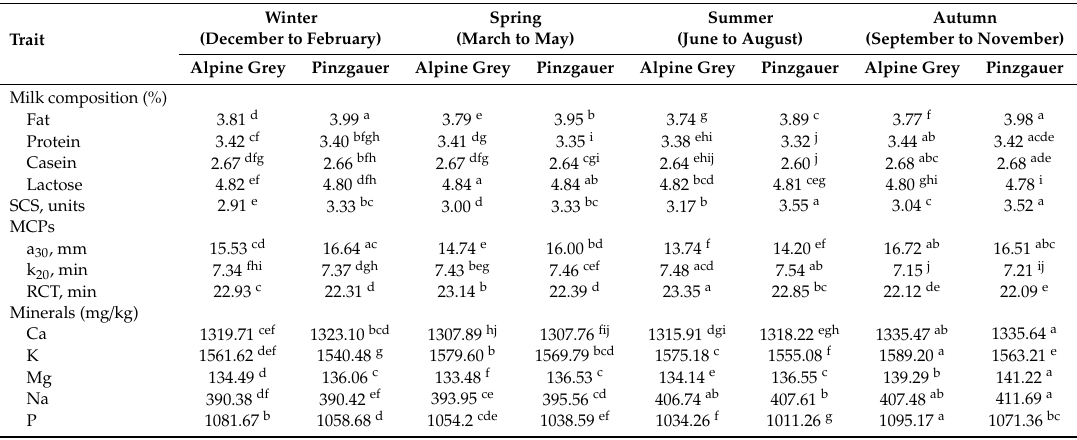
Table 5. Least squares means of bulk milk traits for the interactions between breed and seasons of